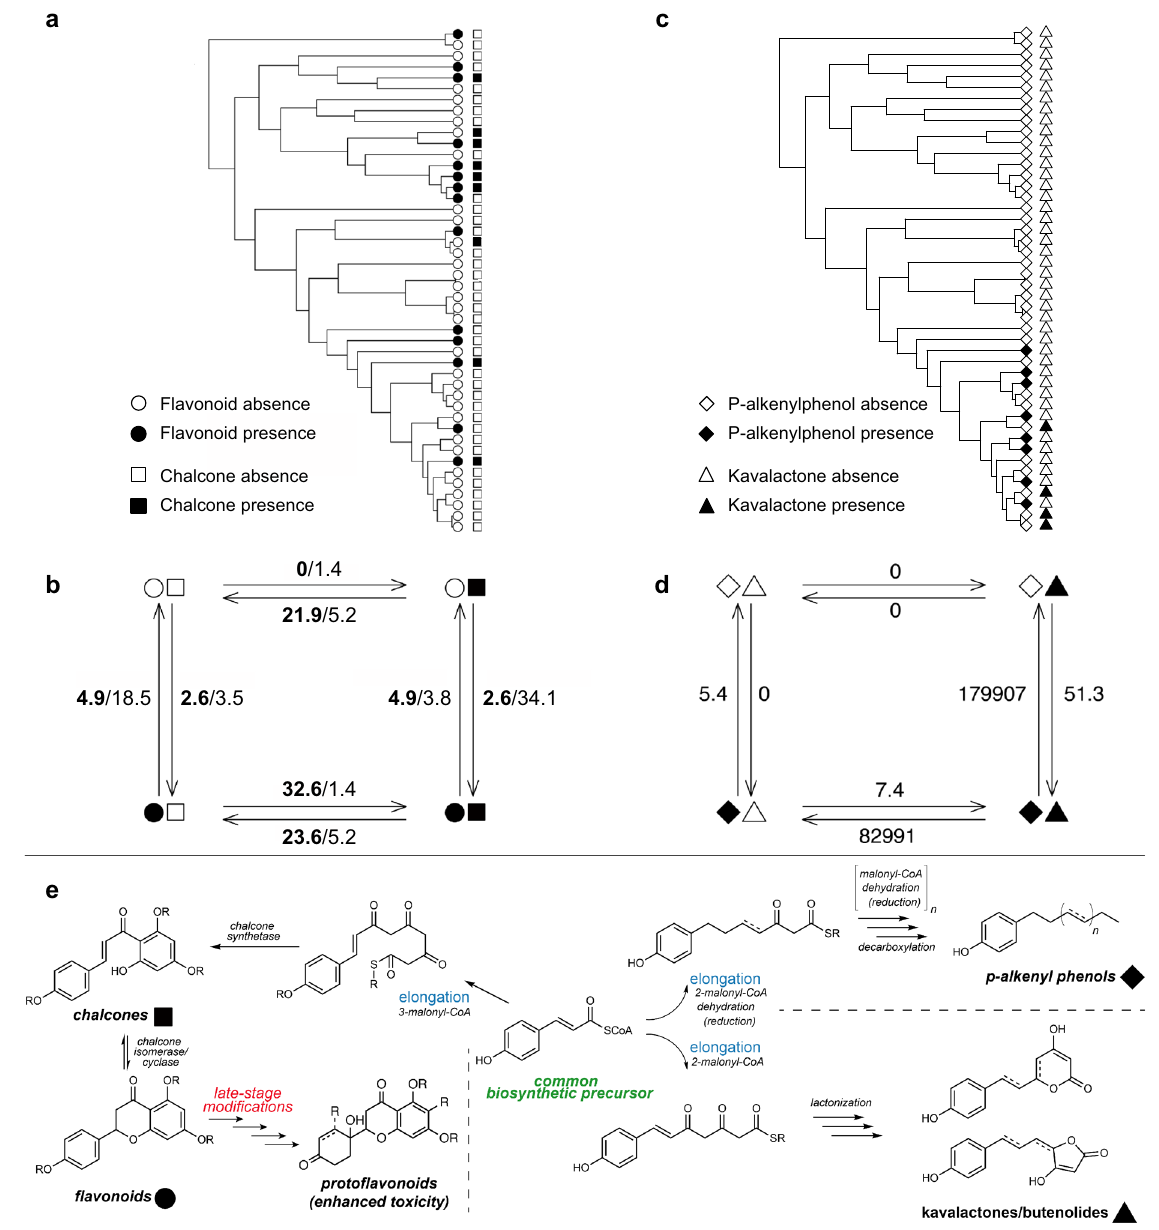
Figure 3. Evolutionary associations were detected in two pairs of traits according to Pagel’s test 76 of correlated evolution: (1) flavonoids and chalcones and (2) p -alkenyl phenols and kavalactones/butenolides. Filled shapes indicate presences and unfilled shapes indicate absences of flavonoids (circles), chalcones (squares), p -alkenyl phenols (diamonds), and kavalactones/butenolides (triangles), respectively. The shapes used in the phylogenetic plots ( a,c ) are repeated below ( b,d ) to depict four states comprising all combinations of presences and absences in the pair of traits. Arrows represent transition rates between states. ( b ) As both models of contingent change provided good fits to the flavonoid and chalcone data, both sets of transition rates are displayed, with the first set of values (bolded) corresponding to the best supported model (chalcone evolution contingent on flavonoid state) and the second set of values corresponding to the alternative contingency model (flavonoid evolution contingent on chalcone state). ( d ) The best fit model to the p -alkenyl phenol and kavalactone/ butenolide data was one of interdependent evolution, where p -alkenyl phenol evolution is dependent on the state at the kavalactone/butenolide trait, and vice versa. Panel ( e ) illustrates the enzymatic processes and branch points along biosynthetic pathways that give rise to the four classes of metabolites. Chalcones are immediate biosynthetic precursors of flavonoids, where the inherent reactivity of the chalcone moiety permits cyclization to the flavonoid scaffold. Subtle structural changes to the flavonoid scaffold caused by late-stage oxidation can produce protoflavonoids, a rare class of metabolite with potent cytotoxic activity. In contrast, the pathways of p- alkenyl phenols and kavalactones diverge much earlier and embark on distinct chain elongation pathways that lead to long-chain lipophilic substituent characteristic of the p -alkenyl phenols in one case, and lactones (kavalactones and butenolides) in the other